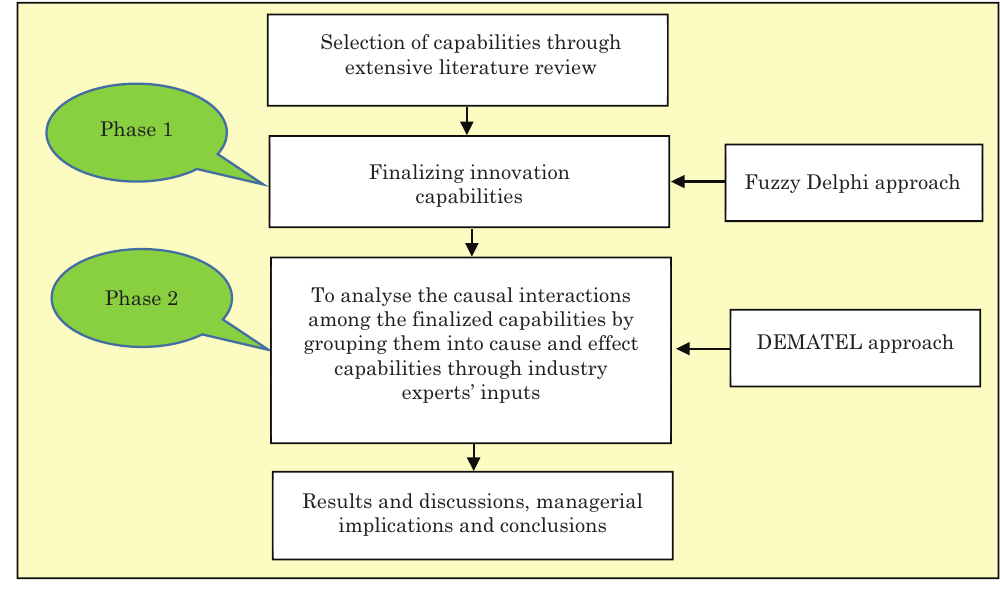
Fig. 2. Proposed research framework